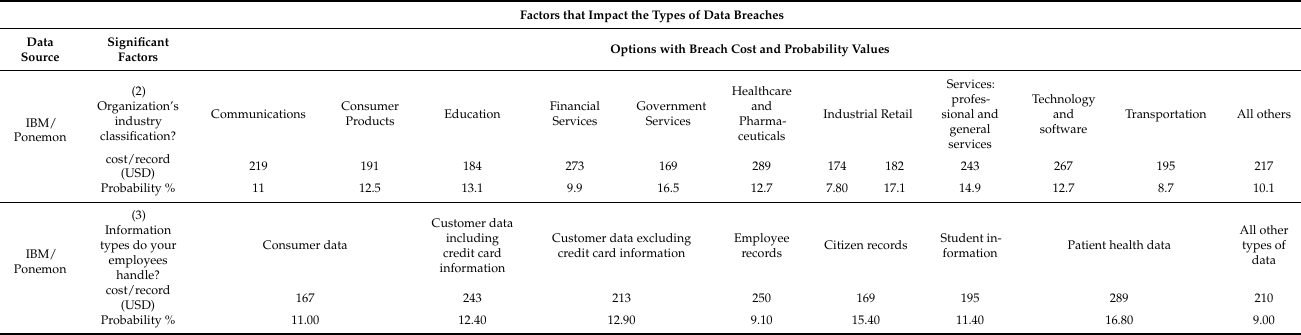
Table 4. The values of data breach costs and the probabilities for the factors associated with data breach